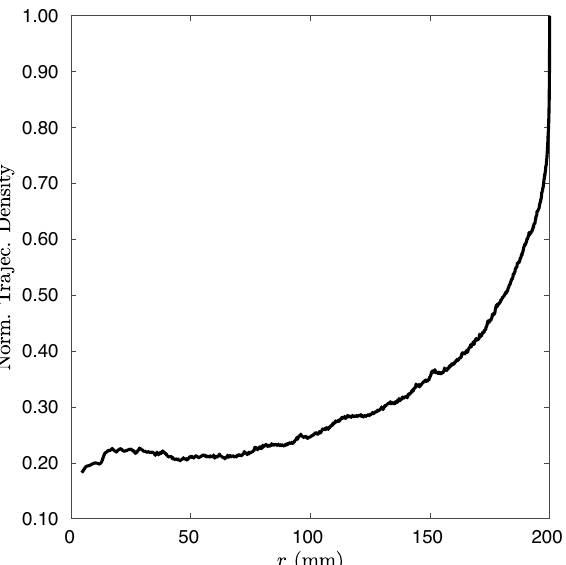
Figure 3. Trajectories density, inside the external source circle for R e =200 mm, versus the radius r normalized at r = R e .